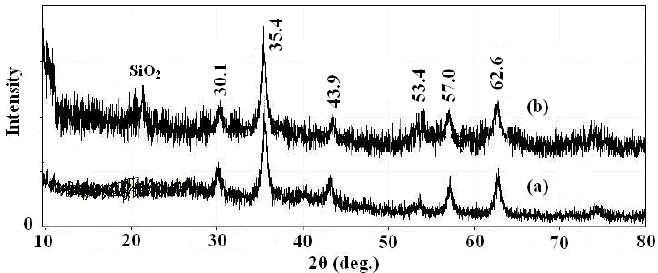
Figure 2. X-ray powder (XRD) patterns of ( a ) Fe 3 O 4 nanoparticles and ( b ) SMN.